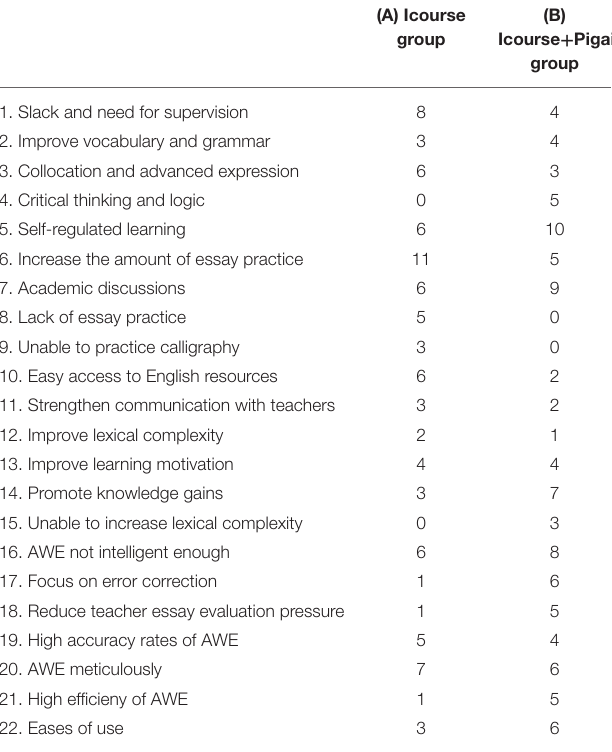
TABLE 7 | Some technology use factors between Icourse group and Icourse + Pigai